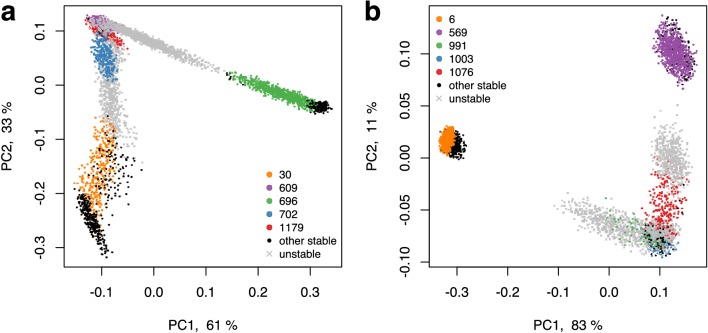
The PCA plot of fractional microbial abundances.These abundances, normalized to 1, were obtained in our simulations for supply rates in the local vicinity of a multistable point where V=5 stable states coexist. Panels (a) and (b) represent the two remaining multistable points in addition to the multistable point shown in Figure 3C. Axes show the percentage of the variance explained by each principal component. Each point show the first (x-axis) and the second (y-axis) principal coordinates of microbial abundances in an uninvadable state feasible for a given set of nutrient supply rates. The supply rates were chosen to be close (±10%) to the initial multistable point. Colored circles mark the original five stable states, black circles - other stable states which became feasible for nearby supply rates, and grey crosses - dynamically unstable states feasible in this influx region. Note a quasi-1D manifold along which the points of all colors are aligned and the alternating order of points corresponding to stable and unstable states.